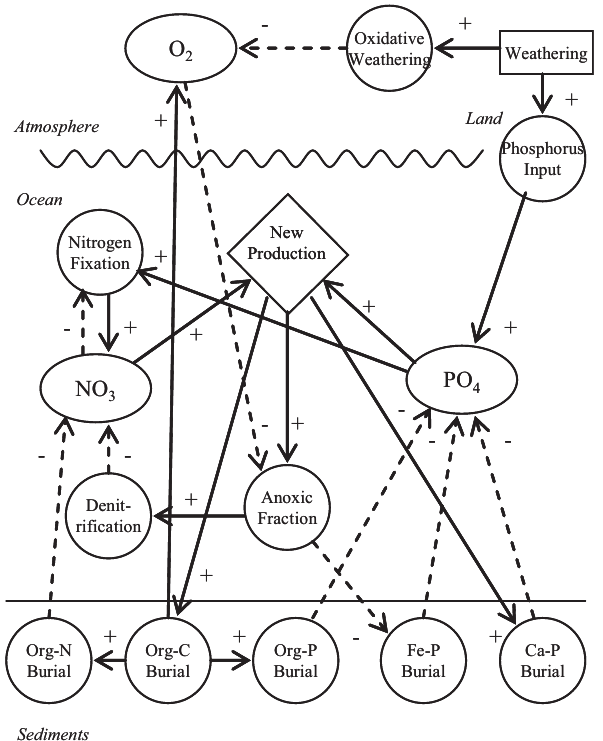
Fig. 1. Feedback diagram of the LW model where arrows indicate causal relationships. Ovals indicate reservoirs, circles indicate de- pendent variables, the diamond indicates a switch – new production is determined by either NO 3 or PO 4 – and the rectangle indicates the single input parameter, weathering. A solid arrow with a plus sign indicates a direct relationship, e.g. increased nitrogen fixa- tion increases NO 3 . A dashed arrow with a minus sign indicates an inverse relationship, e.g. increased NO 3 decreases nitrogen fixa- tion. In this example, a negative feedback loop is closed. All closed loops of arrows that can be traced around the diagram represent feedbacks. If there are an odd number of inverse relationships in a loop it is a negative feedback, whereas those containing none or an even number are positive